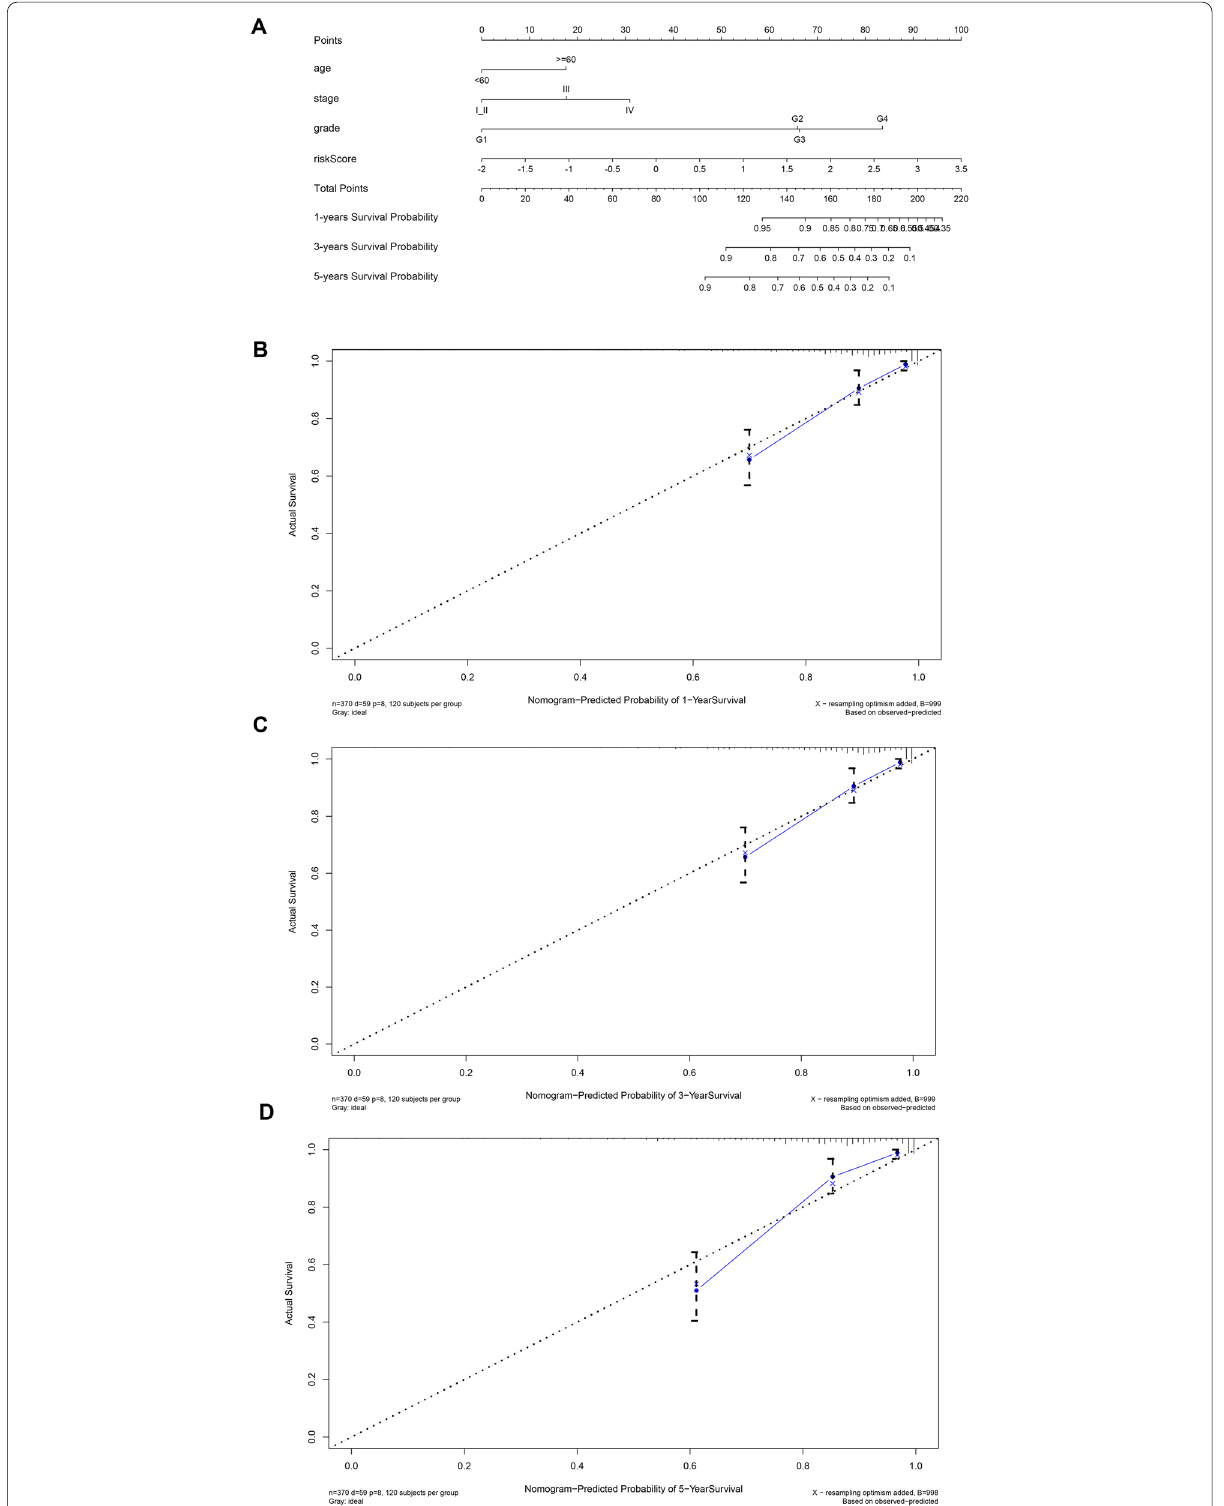
Fig. 4 Construction of a nomogram for prediction survival of EC. A The nomogram to predict 1-, 3-, or 5-year survival rate. B – D The calibration plots for predicting patient 1-, 3-, or 5-year survival